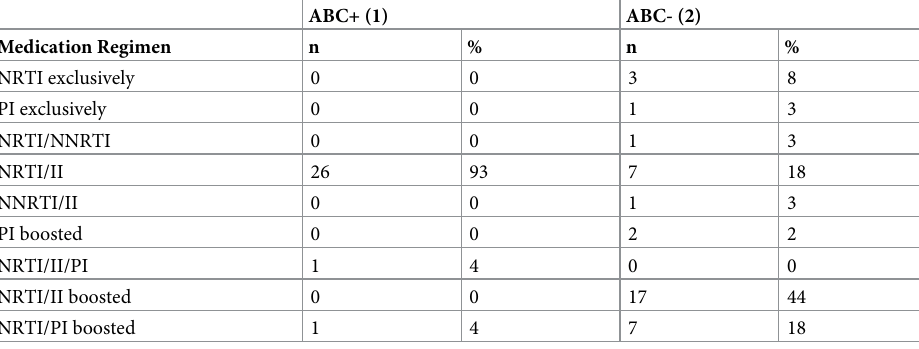
Table 2. ART medication regimens for the ABC+ and ABC- groups.